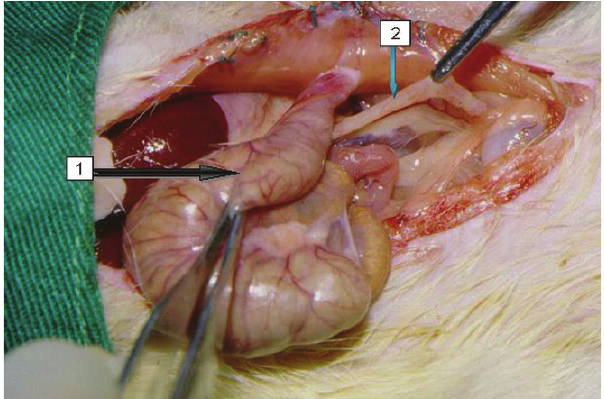
Figure 1 - The macroscopic aspect of the colon of a group B1 animal submitted to intestinal derivation. Arrow 1 indicates the functional intestinal segment, after derivation in intestinal wall colostomy. Arrow 2 shows the defunctionalized segment, with whitish coloration and visibly